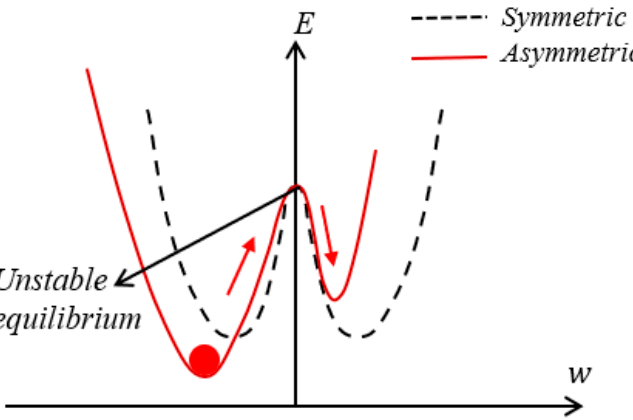
Figure 2. Potential energy diagrams of bistable unsymmetric structures.